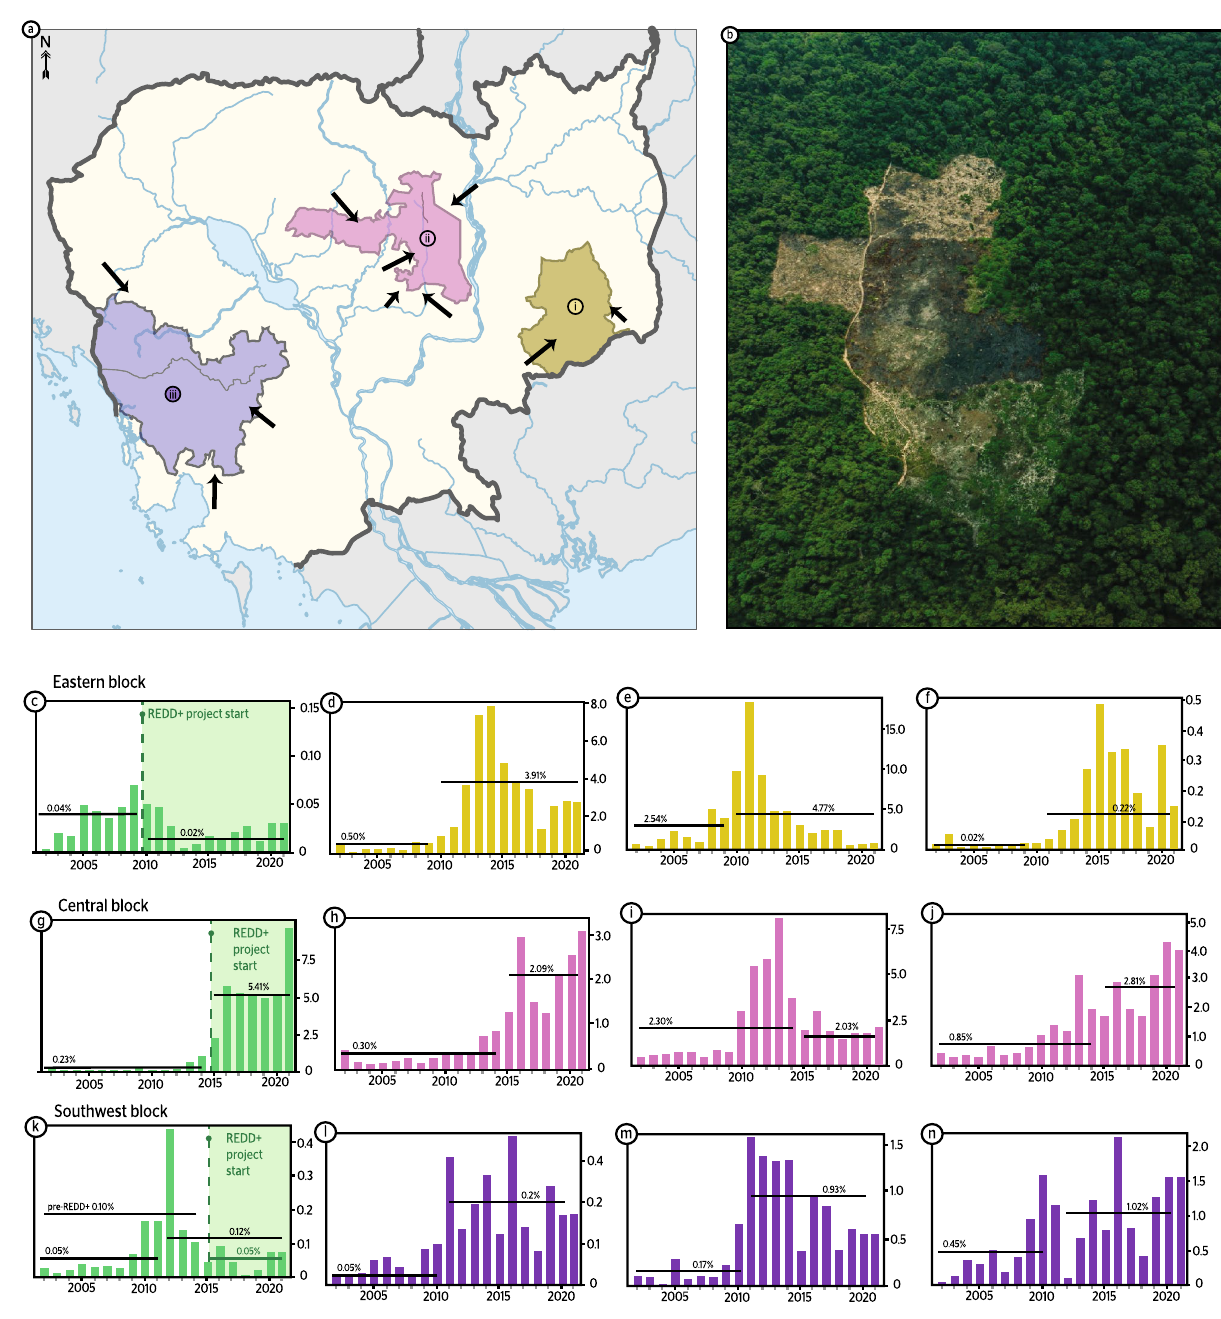
Figure 2. A snapshot of deforestation in three protected area blocks in Cambodia. 12 protected areas and REDD+ projects were analyzed in ( a ) Cambodia in three protected area blocks: (i) eastern, (ii) central, and (iii) southwest; arrows highlight deforestation frontiers. ( b ) An example of deforestation within the central block (credit: Filip Agoo on behalf of Everland LLC). Annual forest loss (% of total forest cover, 2001–2021 7 ) was analyzed for: ( c ) Keo Seima REDD+ Project, ( d ) Keo Seima Wildlife Sanctuary, excluding the core forest, ( e ) Snuol Wildlife Sanctuary, ( f ) Phnom Prech Wildlife Sanctuary), ( g ) Tumring REDD+ Project, ( h ) Prey Lang Wildlife Sanctuary, ( i ) Beng Per Wildlife Sanctuary, ( j ) NorthWest Biodiversity Corridor Segments NWC2, NWC3), ( k ) Southern Cardamom REDD+ Project, ( l ) Phnom Kravanh National Park, ( m ) Phnom Aural Wildlife Sanctuary, and ( n ) Phnom Samkos Wildlife Sanctuary. See Supplementary Fig. 2 for relative locations. Basemap and layers accessed from Global Forest Watch (Creative Commons CC BY 4.0) 15 , finalized on Adobe Illustrator (v26.2.1) 16